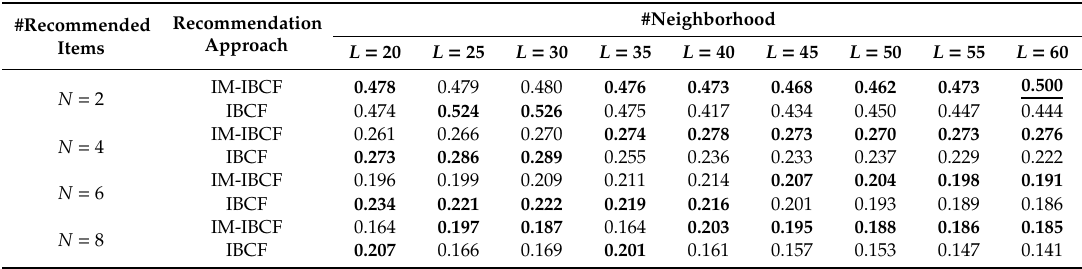
Table 6. Results of precision measure on the MovieLens 100K dataset.